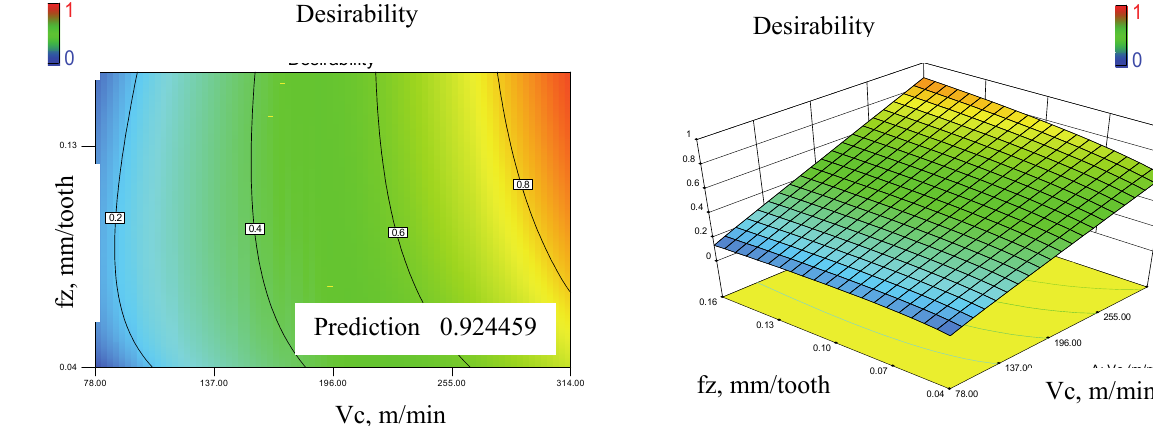
Fig. 11. Contour plot of Composite desirability for Ra, Ry, Rz and MRR